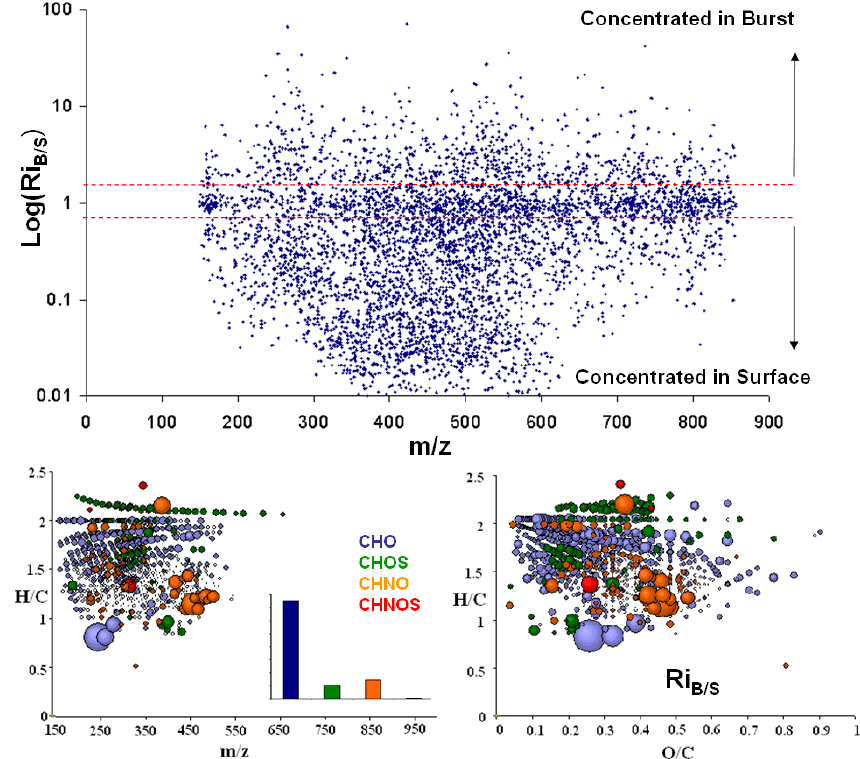
Fig. 4. Analysis of all burst ( B ) data versus all surface ( S ) data based on the intensity ratios (RiB/S) of m/z within 1ppm similarity windows. Differentiation of the m/z intensity enhanced (RiB/S > 2) or depleted (RiB/S < 2) in the burst relative to the surface as illustrated in the van Krevelen diagrams (circle size in the graphs was proportional to the intensity ratios RiB/S). The ratio increased from higher oxygen content towards lower O/C and from lower H/C values (unsaturated and aromatic compounds) towards higher H/C (saturated, aliphatic).